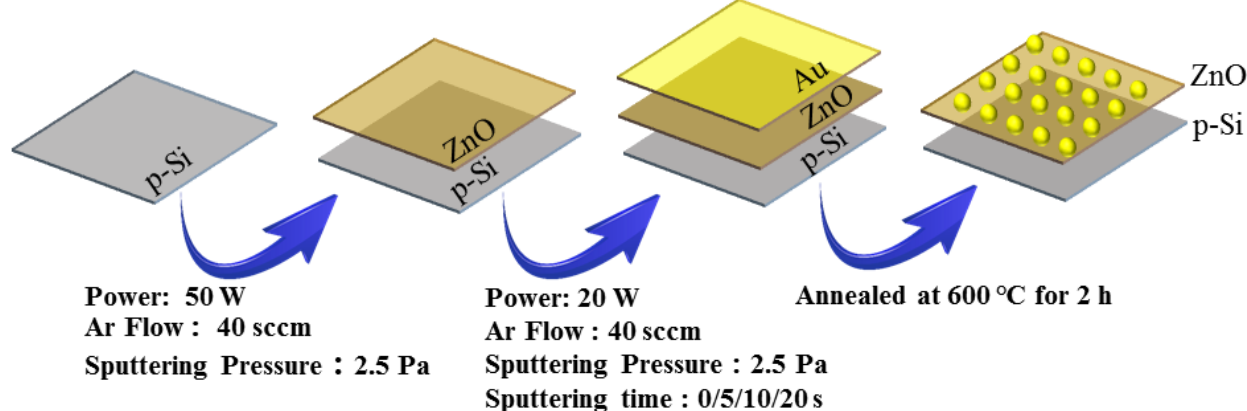
Figure 1. Schematic illustration for the preparation process of Au@ZnO nanofilms.